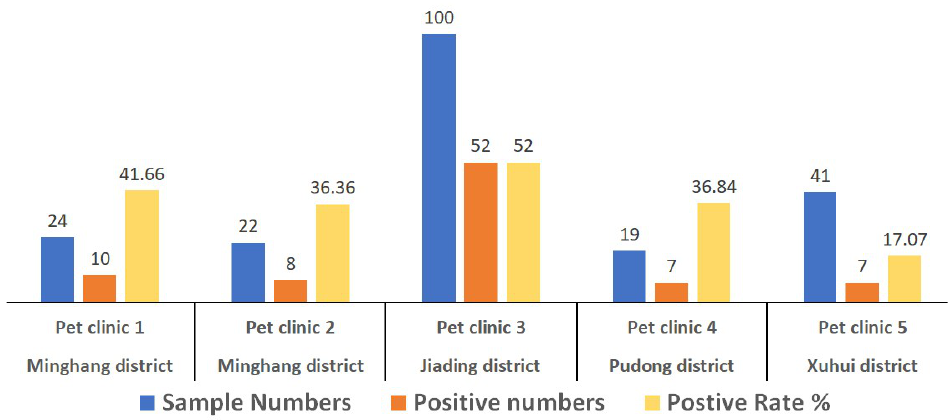
Figure 1. Positive detection rate of CPV-2 in canine patients. A total of 206 fecal specimens from canine patients collected from five pet clinics in four urban districts of Shanghai (Minhang, Jiading, Pudong, and Xuhui) were tested for CPV-2 using the PCR method.